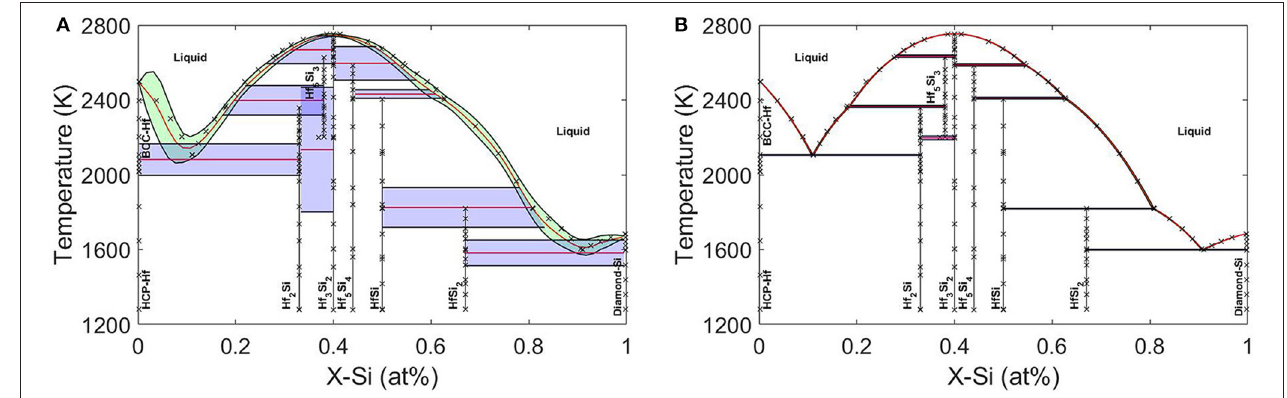
FIGURE 13 | Error correlation-based model fusions of (A) three models (1, 3, and 4) and (B) all four models.Reproduced with permission from Honarmandi et al.